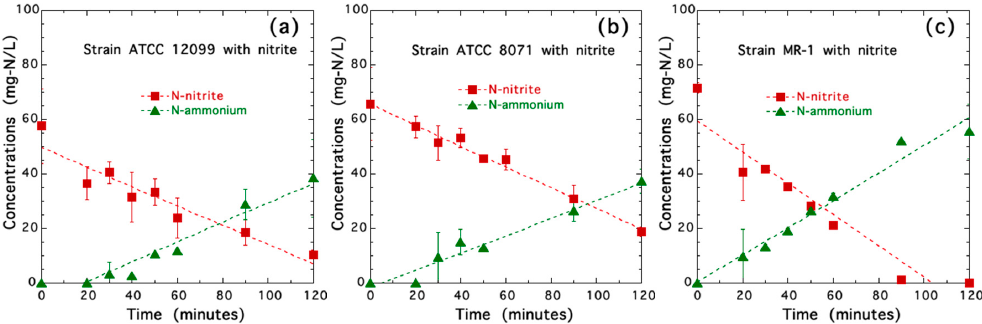
Figure 7. Nitrite reduction by S. putrefaciens ATCC 12099 ( a ), S. putrefaciens ATCC 80.71 ( b ) and S. oneidensis MR-1 ( c ). All experiments were performed in triplicate, except for S. oneidensis MR-1 for which experiments were carried out in duplicate. Error bars correspond to standard deviations of triplicate or duplicate experiments. Experimental data were fit using a linear regression model. Minerals 2020 , 10 , x FOR PEER REVIEW